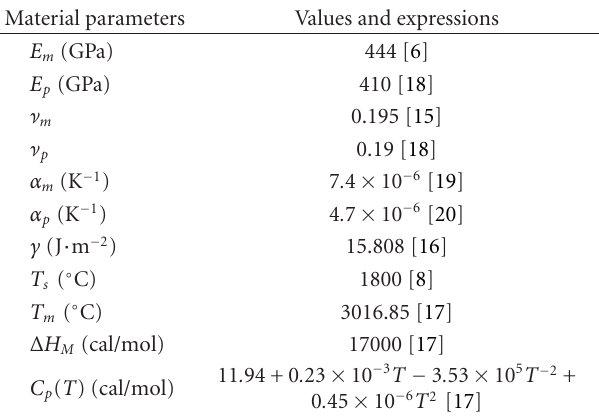
Table 1: Temperature-dependent material properties of TiC. Material